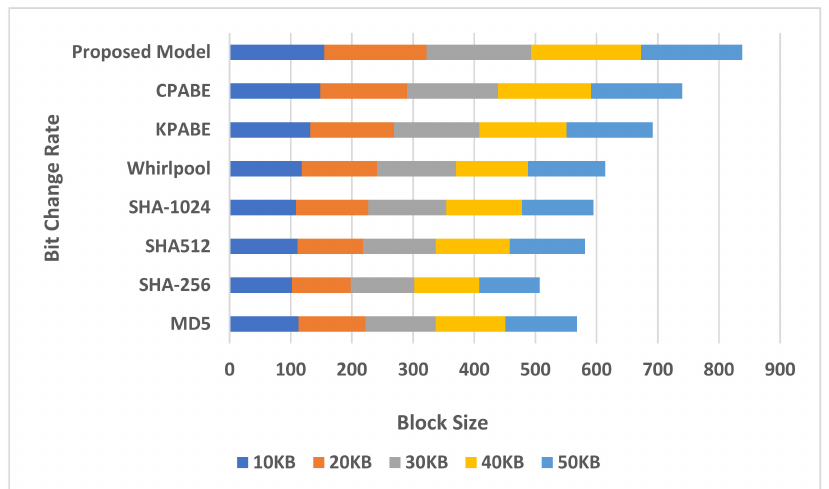
Figure 9. Computational time band for chaotic key